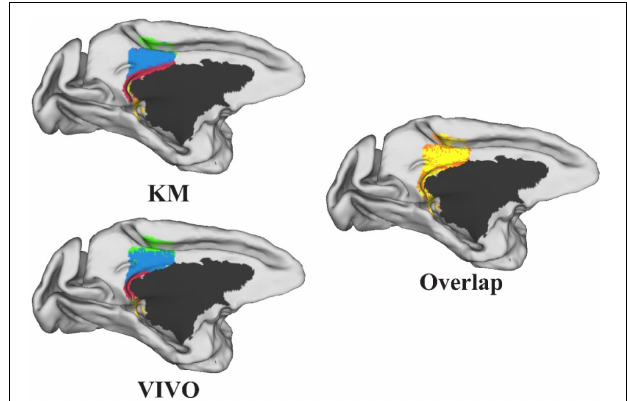
FIGURE 9 | The parcellation results of the left posterior cingulate gyrus on the two datasets and the overlap between the two parcellation results. All the results were transformed and combined into F99 brain space. The yellow-shaded areas represent areas of overlap, and the orange-shaded areas represent the